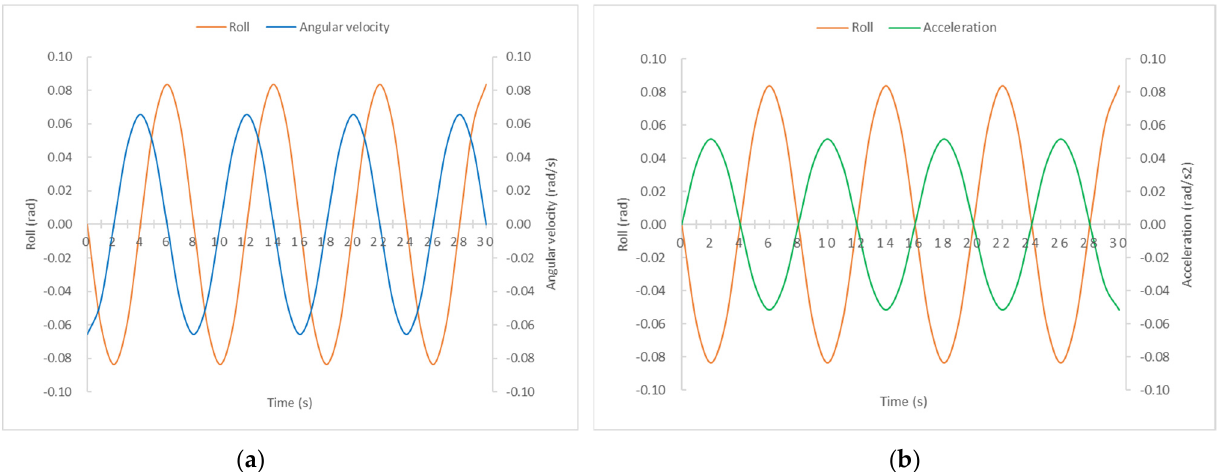
Figure 3. Rolling motion induced only by waves of Tw = 8 s in a ship with Td = 12 s and without resistance. ( a ) Rolling angle and angular velocity vs. time ( b ) Rolling angle and acceleration vs. time.